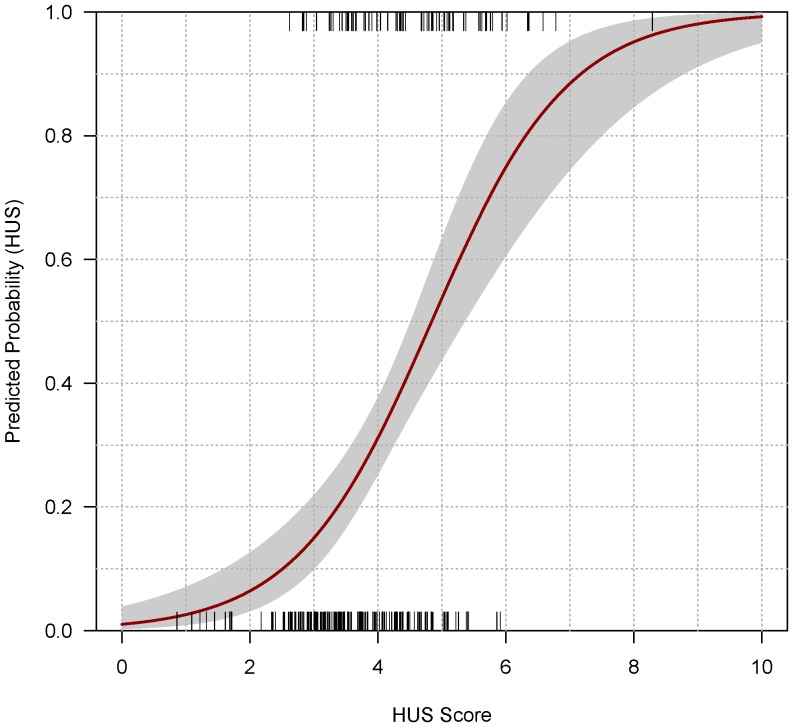
Predicted probability for HUS according to risk score.Grid (“rug”) above indicates observed HUS cases and corresponding scores, grid below indicates patients without HUS and corresponding scores. 95% confidence interval is in grey shades.